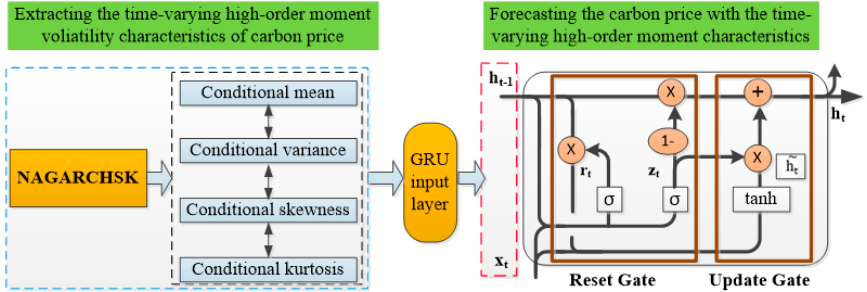
Figure 2. The structuring idea of the carbon price-forecasting hybrid model of NAGARCHSK–GRU.